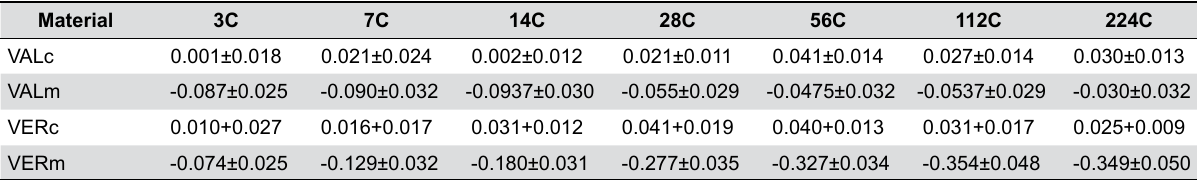
Table 1- Length difference (ΔLen) in mm with standard deviation (±) of all groups at all